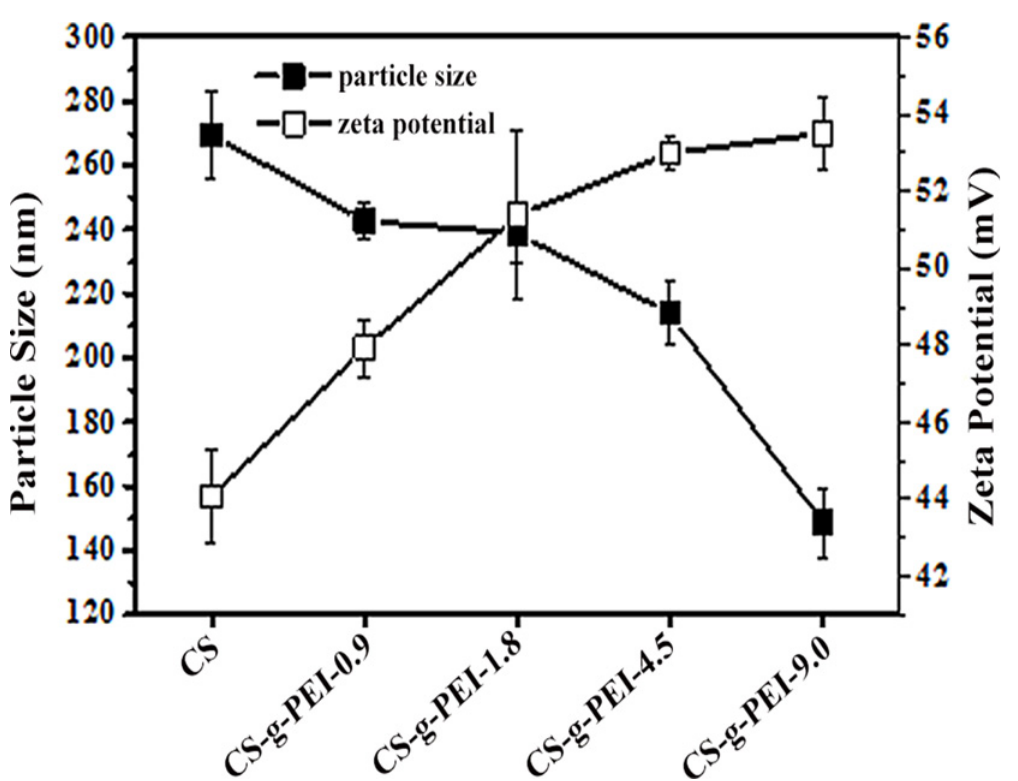
Fig 7. Particle sizes and ζ -potentials of CS/pDNA and CS- g -PEI/pDNA polyplexes (N/P = 6) determined by DLS.